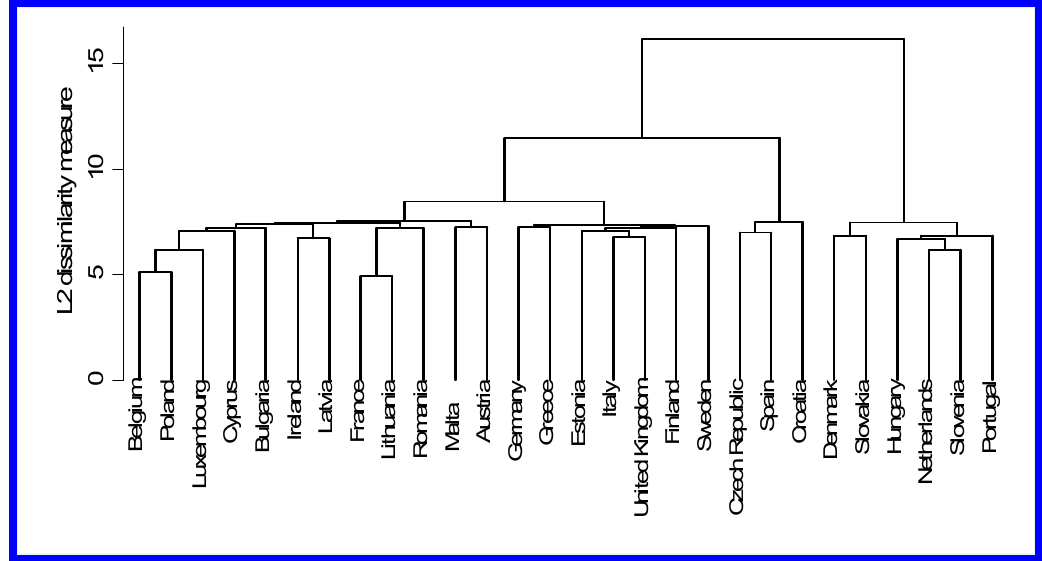
Figure 2. Dendrogram by Ward’s method.